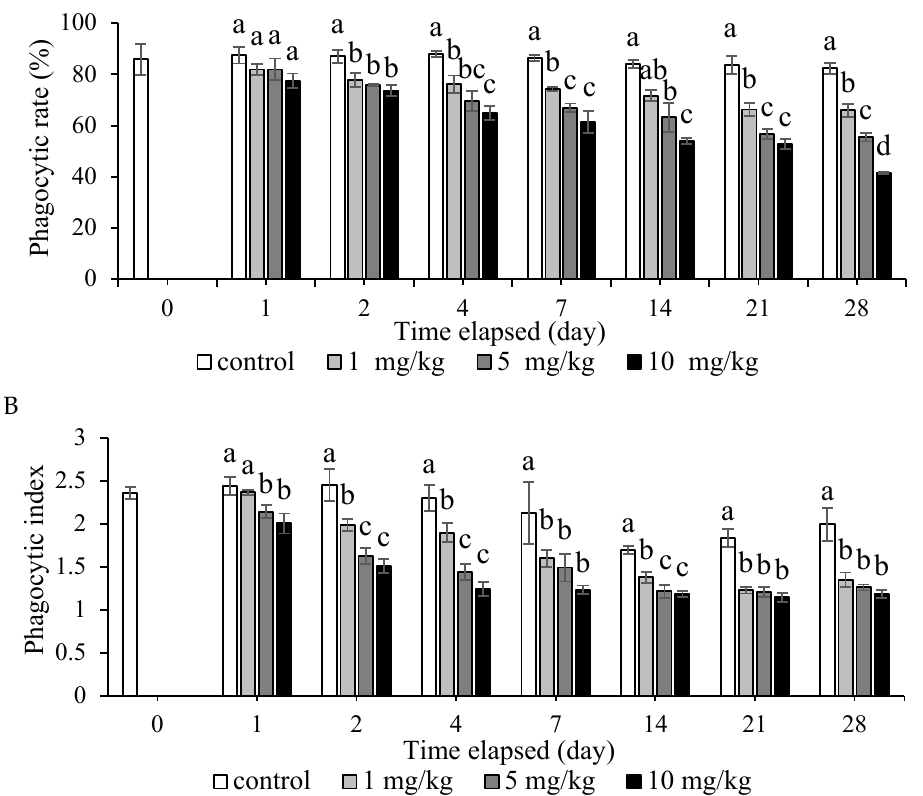
Figure 4. Phagocytic rate ( A ) and phagocytic index ( B ) of hybrid grouper fed with various concentra-